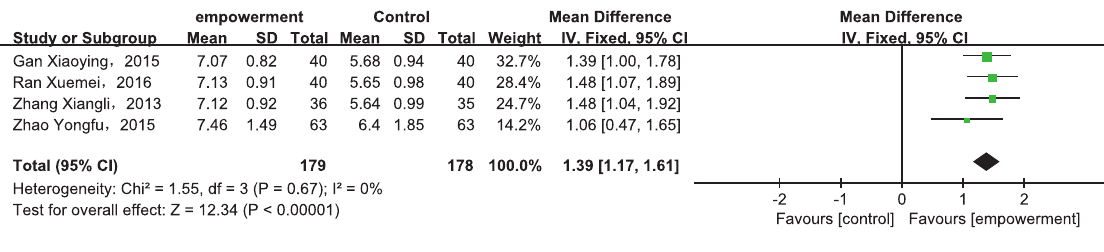
Figure 4. Comparison of 6-month self-efficacy between empowerment education intervention group and traditional education group.